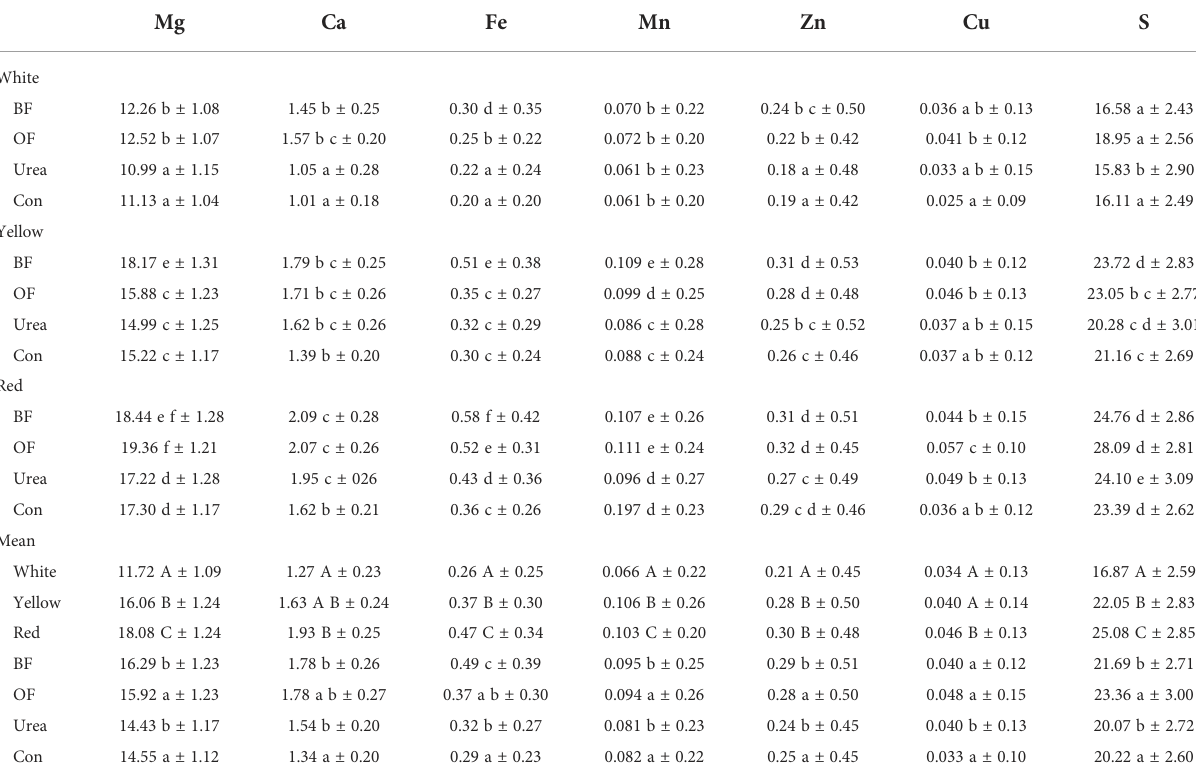
TABLE 5 Effect of different fertilizer treatments (biofertilizer (BF); organic fertilizer (OF); urea; control (Con; no fertilizer)) and maize kernel colors on the removal of the analyzed elements with the grain yield (kg ha -1 ) (average of 2018 – 2020). Mg Ca